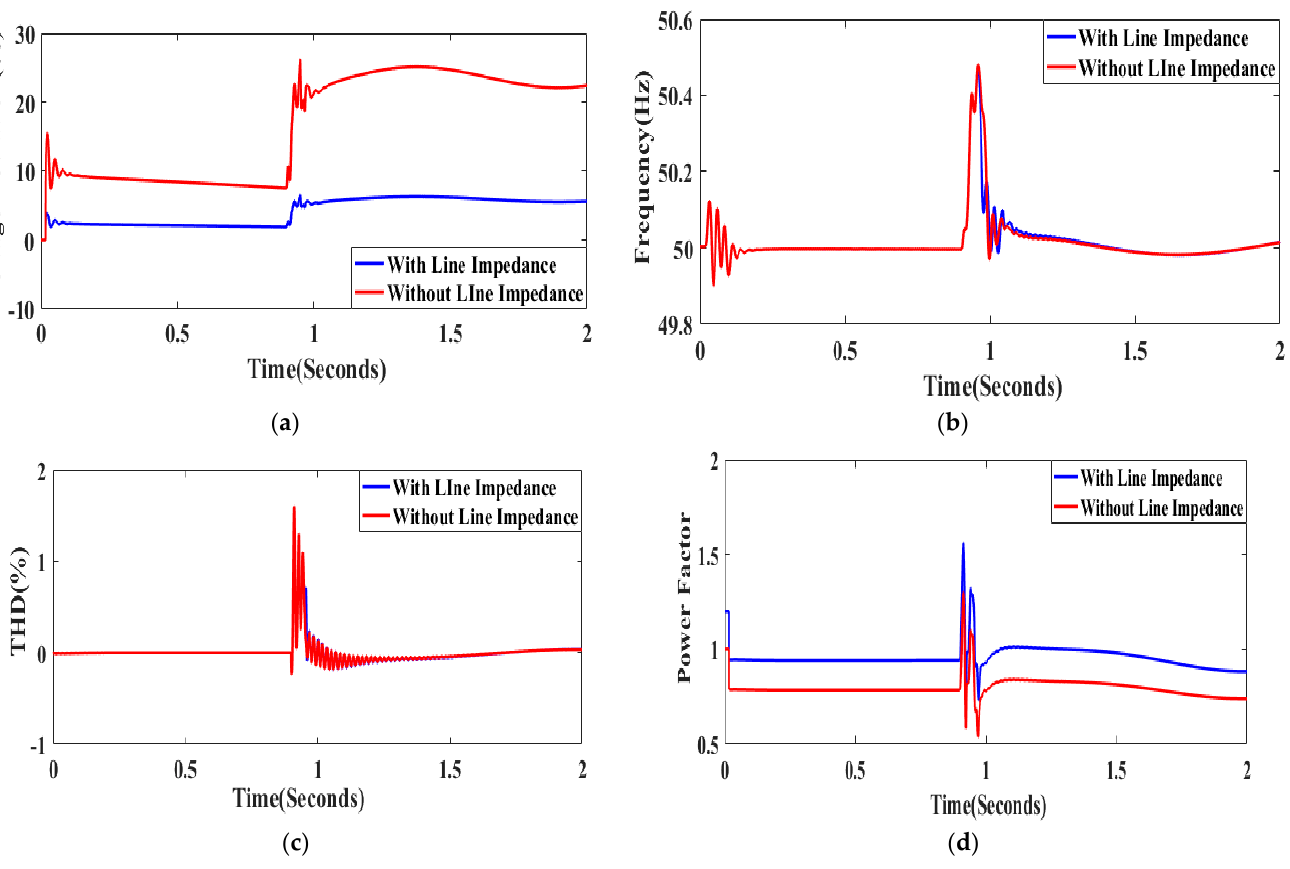
Figure 16. ( a ). Voltage deviation with/without influence of LI. ( b ) THD with/without influence of LI. ( c ) Frequency with/without influence of LI. ( d ) Power Factor with/without influence of LI. Table 7. Influence of LI on power loss in generation and distribution